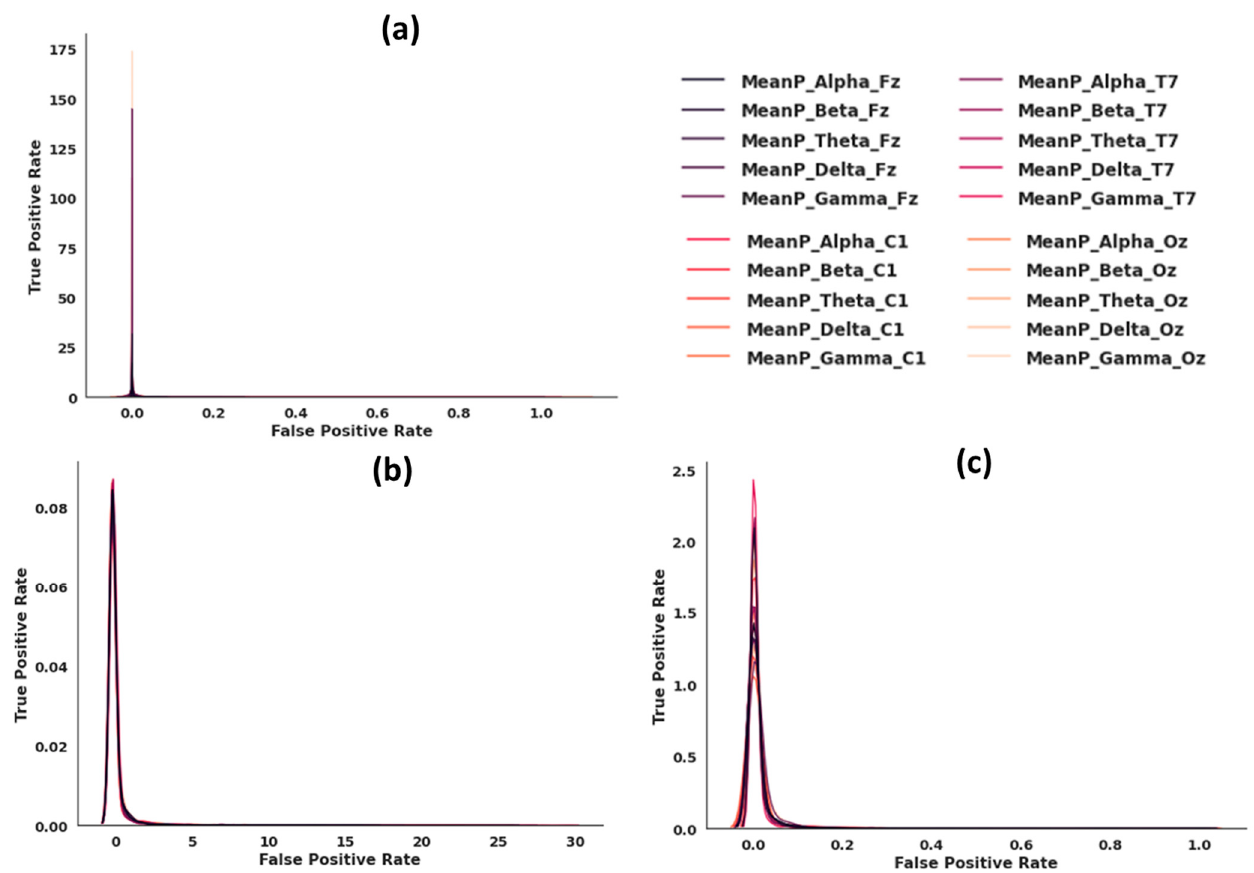
Figure 2. ( a ) Data distribution with no feature scaling. ( b ) Data distribution with standard feature scaling. ( c ) Data distribution with min-max feature scaling.